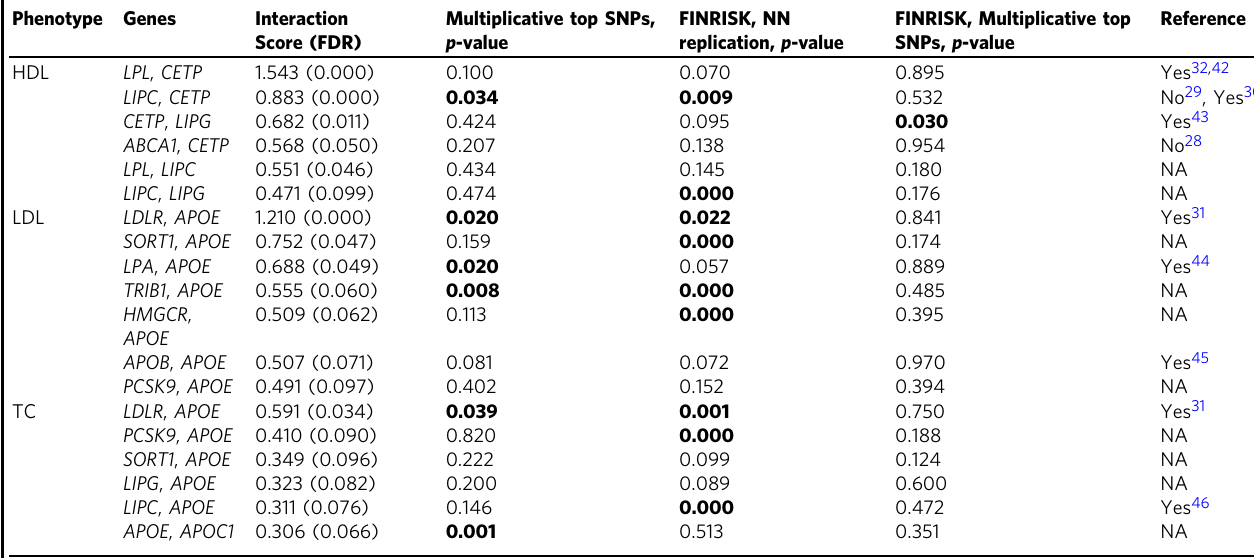
First column shows the three phenotype in the study. Second column shows the corresponding pair of genes, third column the interaction score and the false discovery rate. The p -values using the top- SNP method are shown in the fourth column, where bold highlights p -value <0.05 (with 424,389 independent samples). The replication results on FINRISK ( p -values, with 4620 independent samples) are shown in the fi fth column. The p -values (with 4620 independent samples) using the top-SNP method on FINRISK are shown in the sixth column, and only one interaction is signi fi cant. The last column gives a reference from previous literature (if any), where ‘ Yes ’ and ‘ No ’ denote whether the interaction is known/found or not, and ‘ NA ’ denotes that there are no related